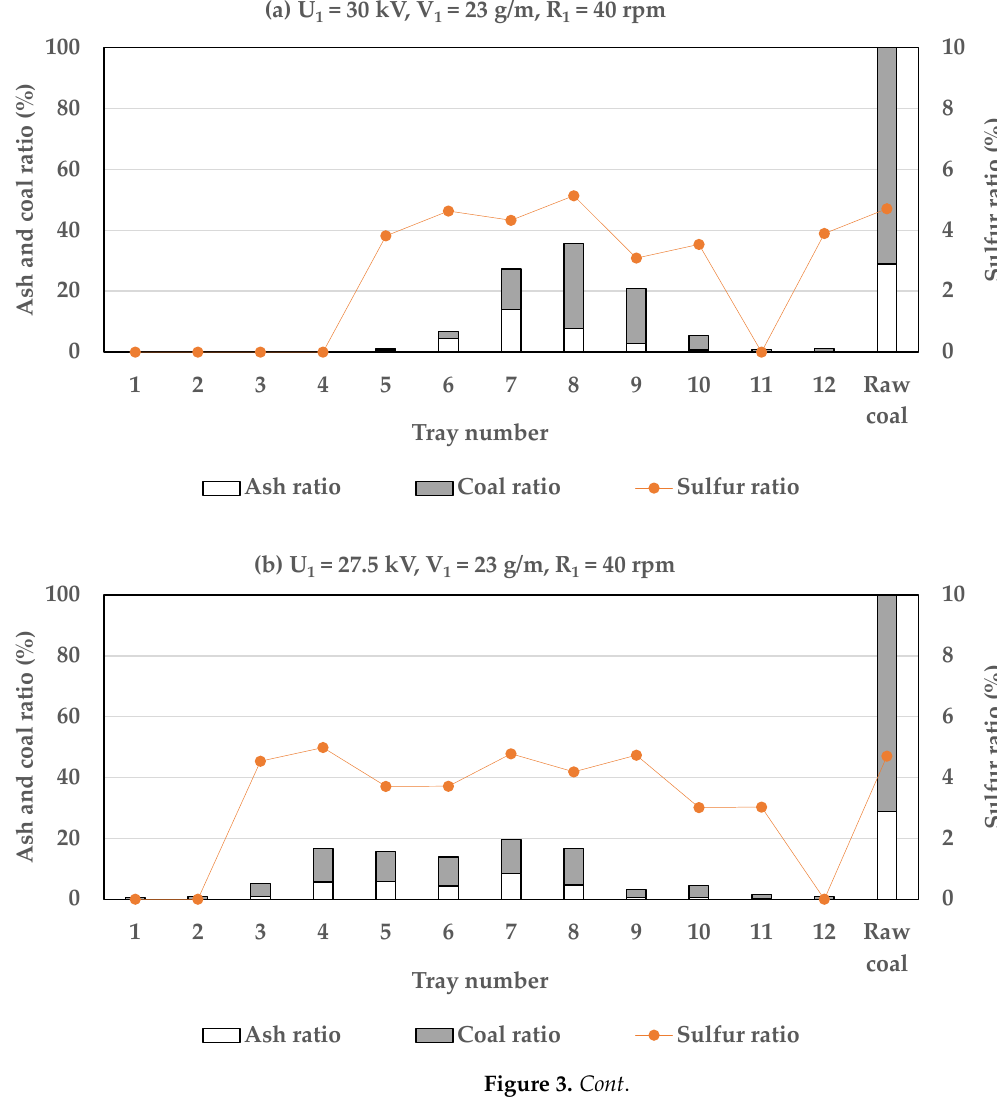
Figure 3. Ash ratio (%), coal ratio (%), and sulfur ratio (%) of particles collected from tray numbers 1–12 at different elec- trode voltages: ( a ) 30 kV; ( b ) 27.5 kV; ( c ) 25 kV using a dry coal cleaning system with two-stage corona electrostatic pro- cesses.